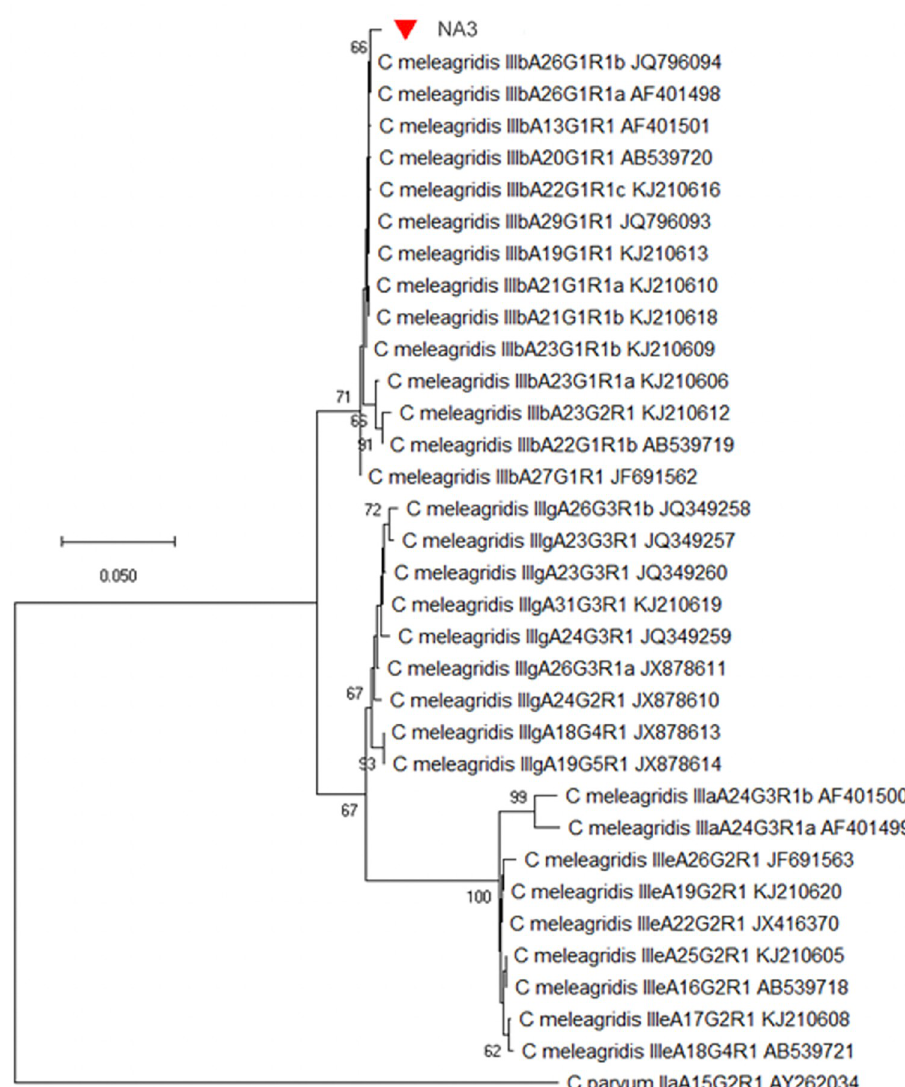
Fig 3. Phylogenetic relationships of Cryptosporidium meleagridis at the gp60